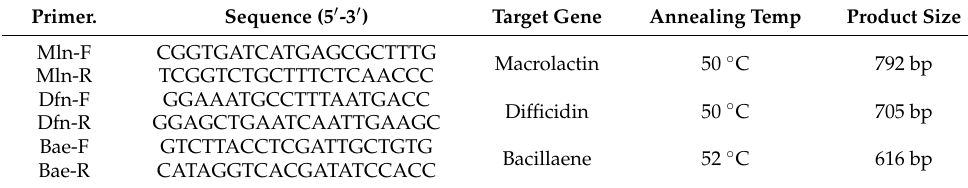
Table 1. List of polyketides primer sets used for multiplex PCR under this study.